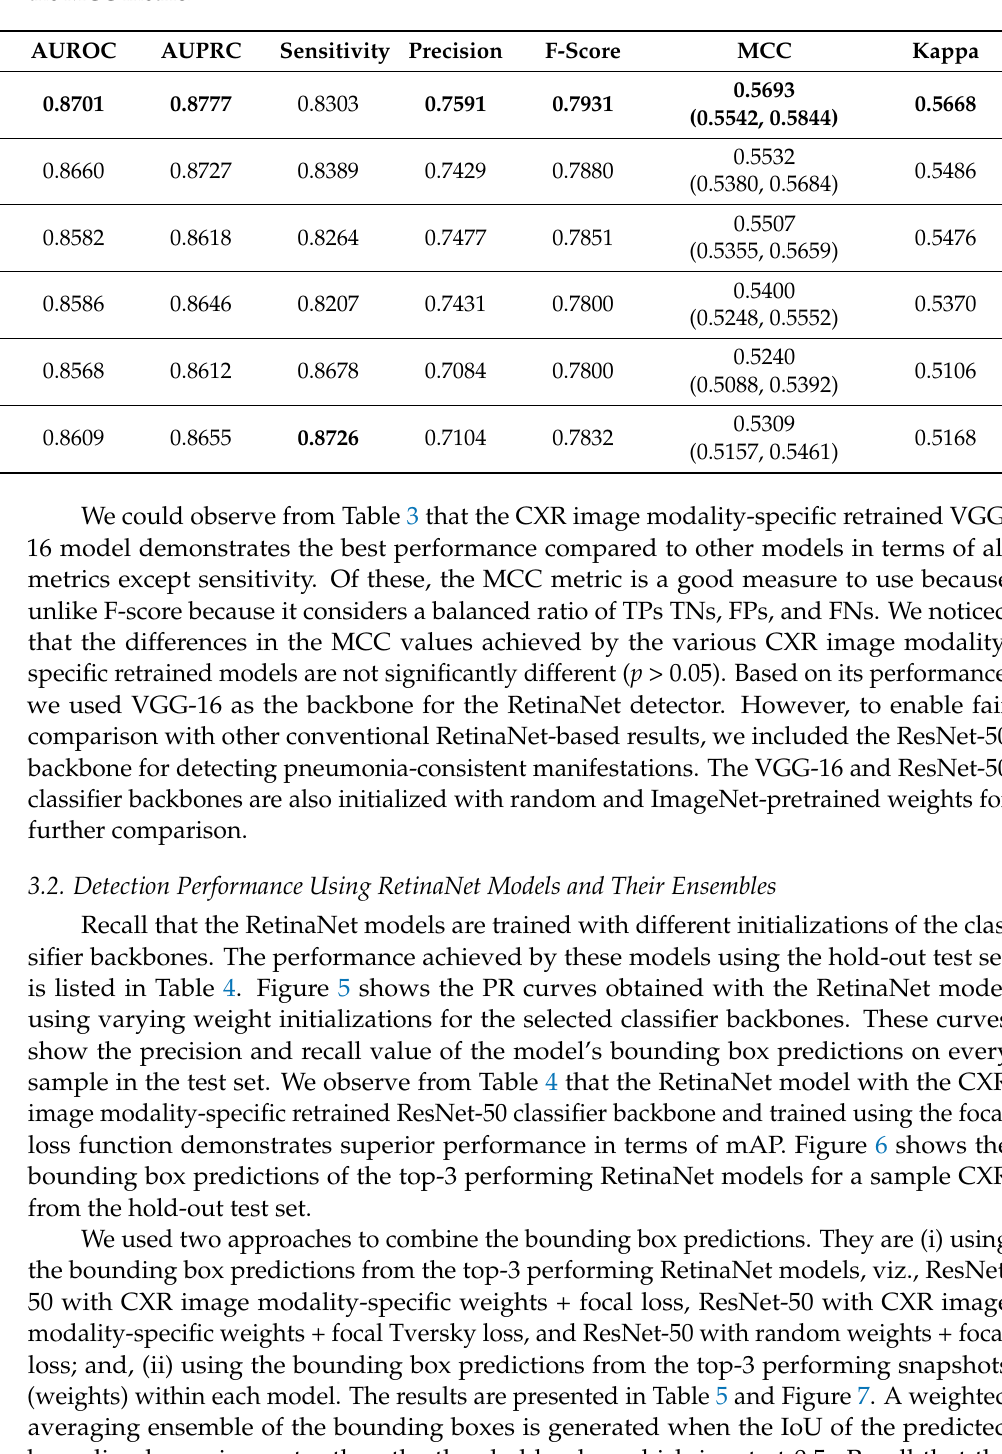
Table 3. Performance of the CXR image modality-specific retrained models with the hold-out test set. Bold numerical values denote superior performance. The values in parenthesis denote the 95% CI for the MCC